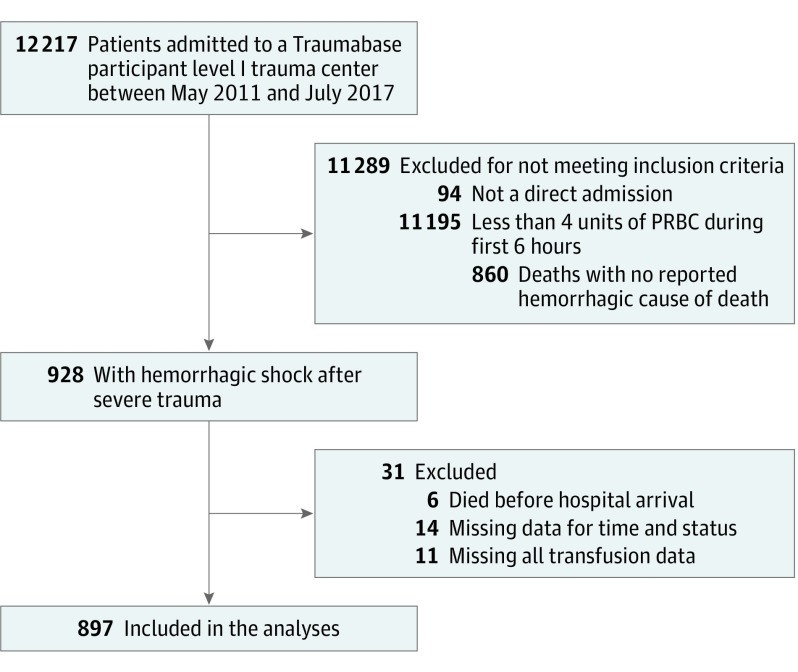
Study FlowchartPRBC indicates packed red blood cells.